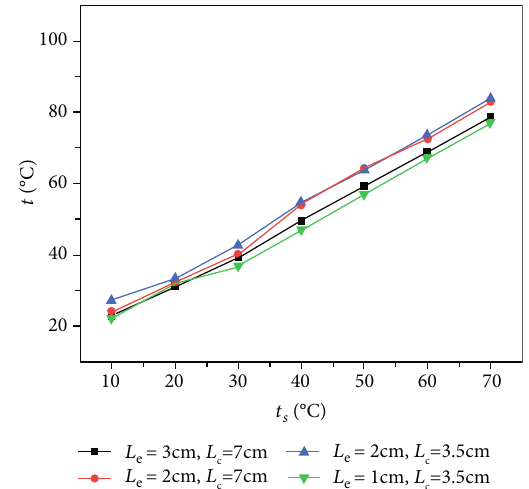
Figure 4: E ff ect of cooling temperature on the critical heat fl ux. Figure 5: E